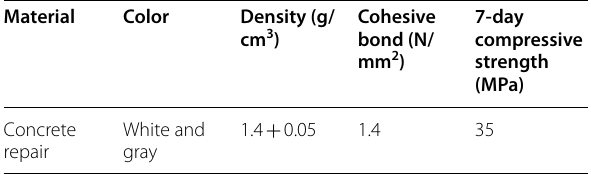
Table 6 Specification of concrete